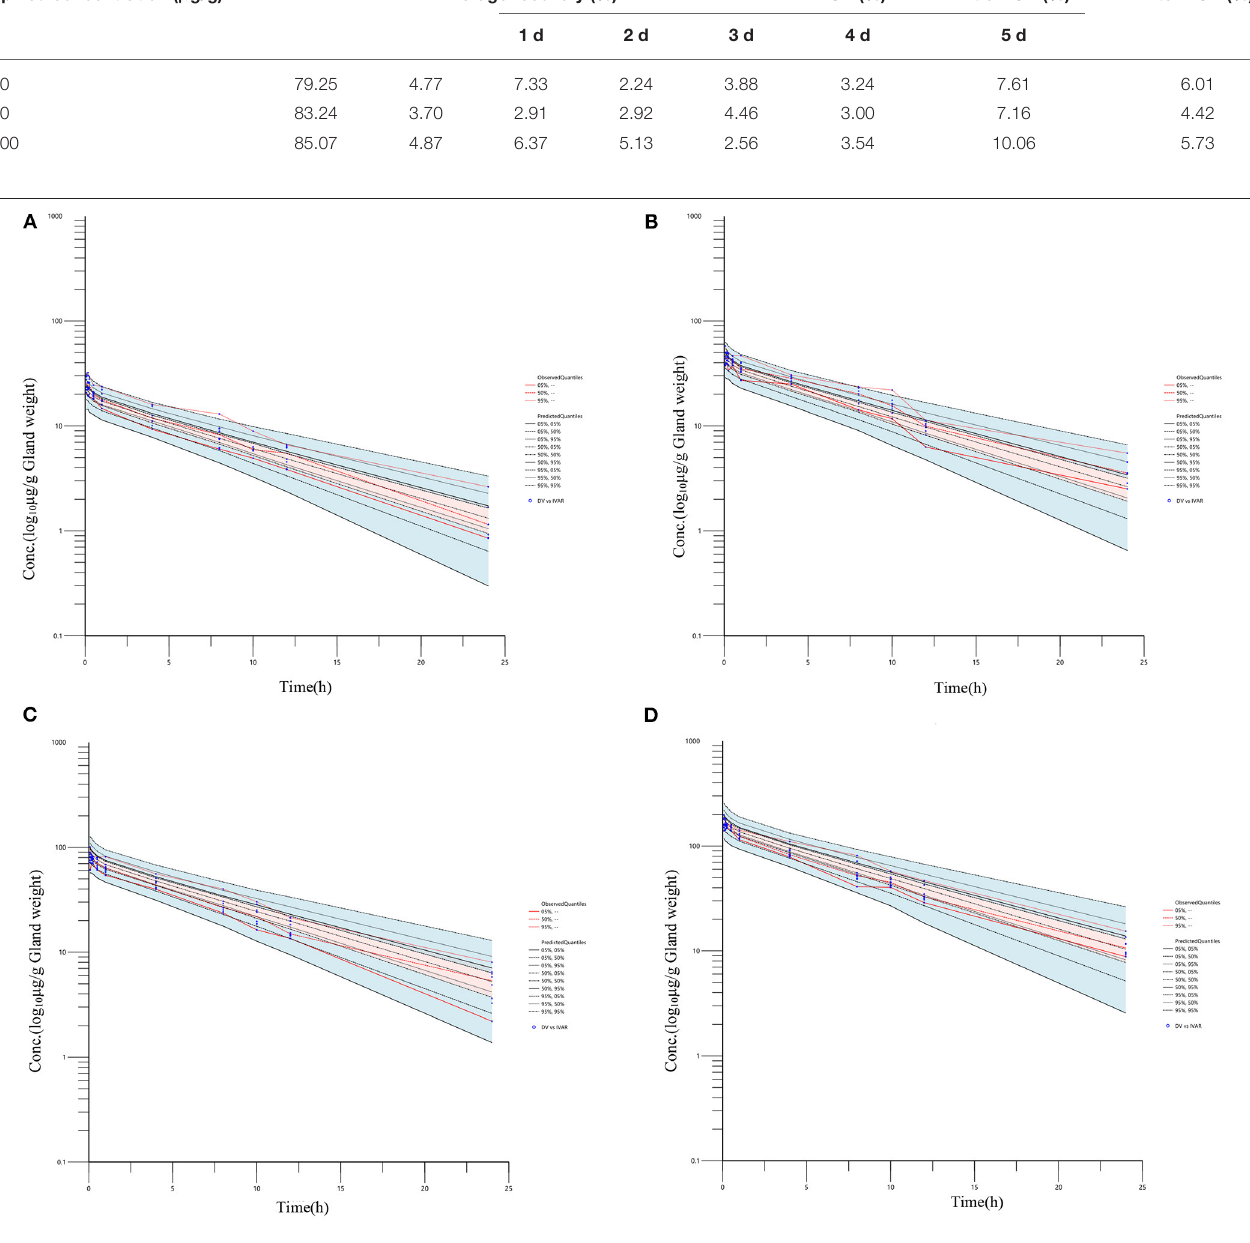
FIGURE 2 | Rifaximin concentration vs. time profile in mammary gland following an intramammary administration dose of 50, 100, 200, and 400 µ g/gland. Plotted symbols show the observed concentration data, and the lines show the results of visual predictive checks. For simulated data, the 5th, 50th and 95th percentiles of the final model simulated data are displayed; for real data, the 5th, 50th, and 95th percentiles of the observed concentrations are displayed. ( A–D represents 50, 100, 200, and 400 µ g/gland, respectively).